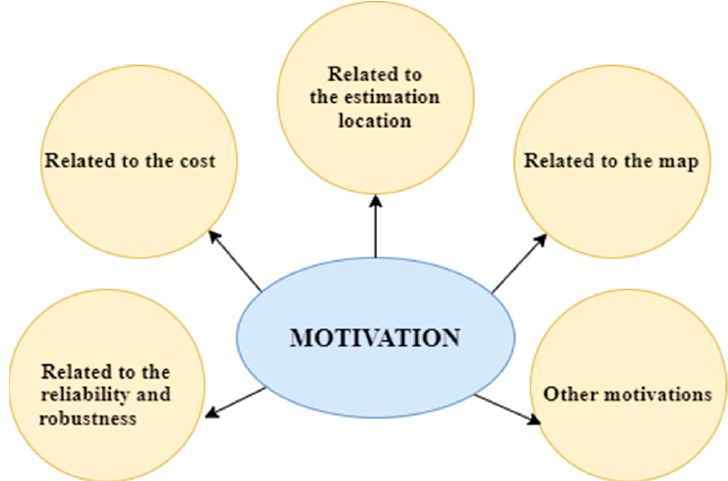
Figure 5. Overview of motivations.